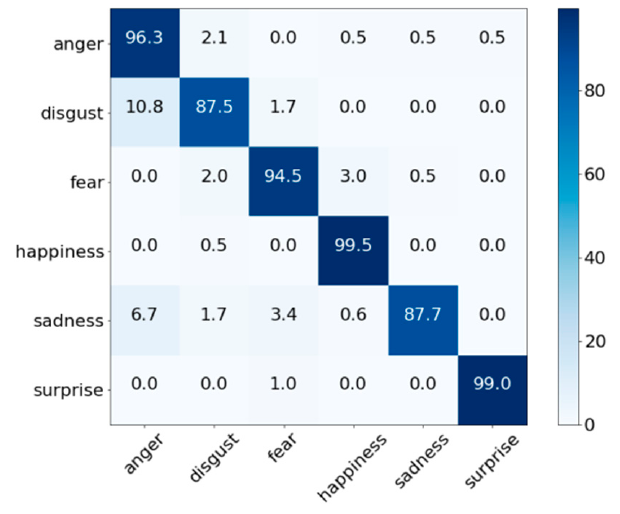
Figure 6. Confusion matrices of the proposed method using the KMU-FED database captured from a moving vehicle.